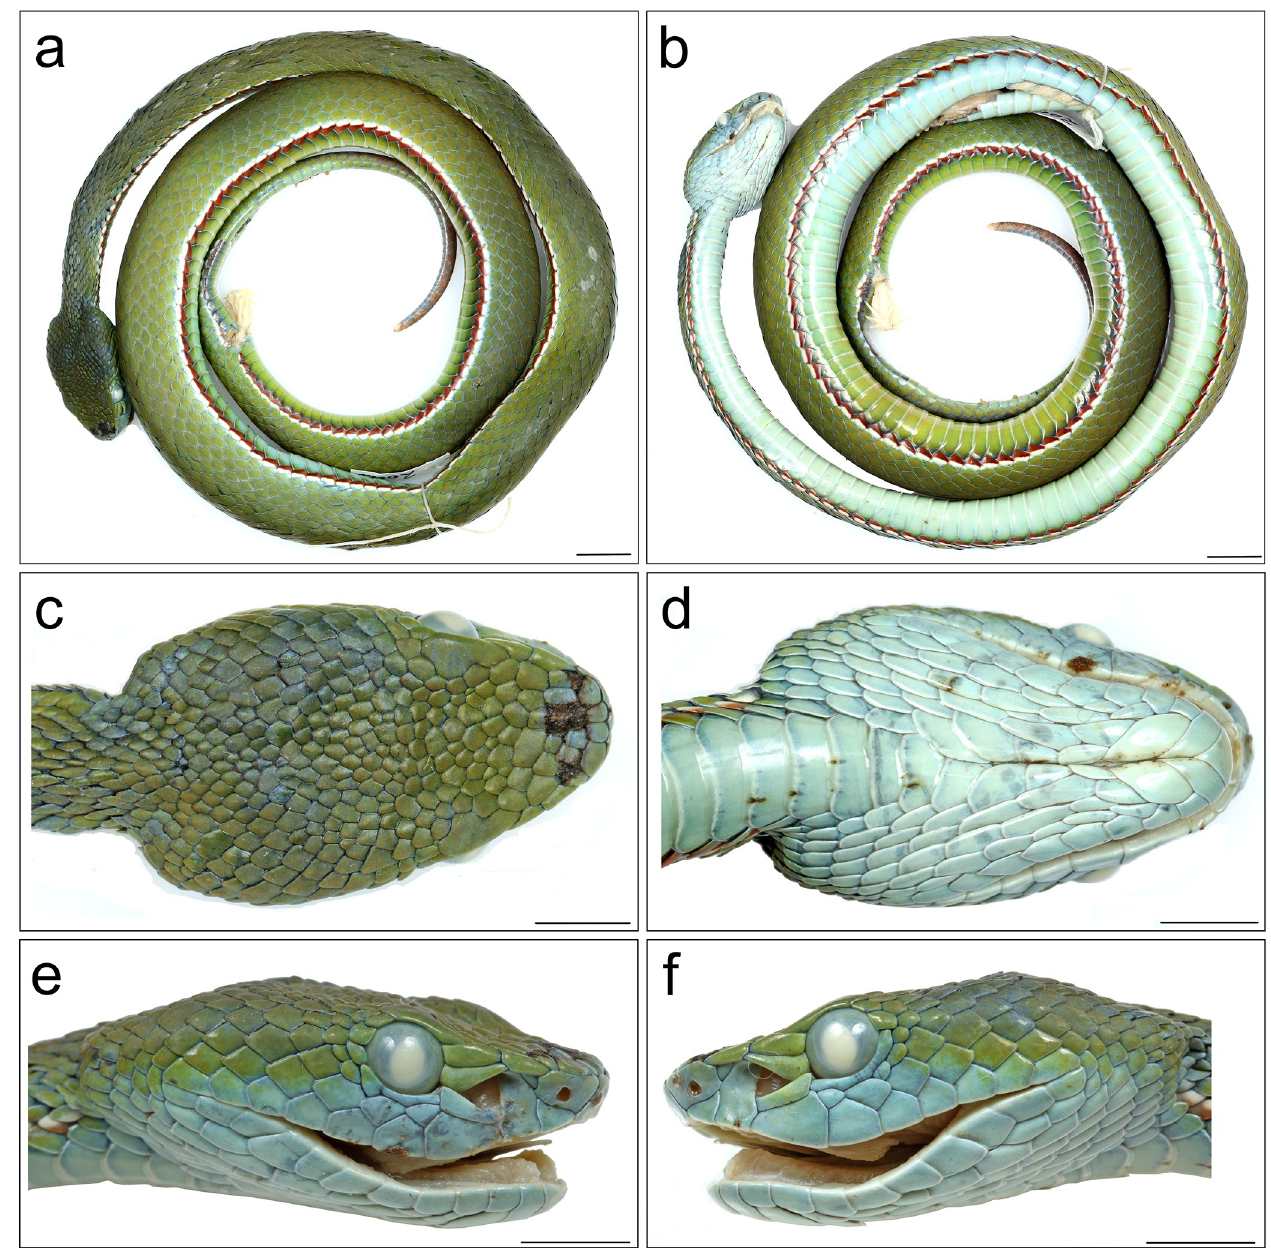
Fig 3. Trimeresurus mayaae sp. nov. holotype male NCBS NRC-AA-0012. (a) dorsal view, (b) ventral view, (c) head dorsal, (d) head ventral, (e) head lateral right, (f) head lateral left. Scale bar (a-b) 20mm, (c–f) 10mm. Photos by Zeeshan A. Mirza. posteriorly and in contact with temporal scales; 10/11 infralabials, the first pair in contact with each other; the first three pairs in contact with anterior chin shields; six pairs of chin shields, 1 st , 2 nd , 5 th and 6 th contact medially, 3 rd and 4 th separated by a pair and a single small scale respectively; separated from infalabials by 1–5 scale rows (Fig 2C). Body scalation: 21 dorsal scales one head length behind the head; 19 dorsal scales at mid- body; 17 dorsal scales one head length anterior to the vent; dorsal scales rhomboid, moderately keeled except for the first row, which is smooth; two preventrals; 157 ventral scales;, 54